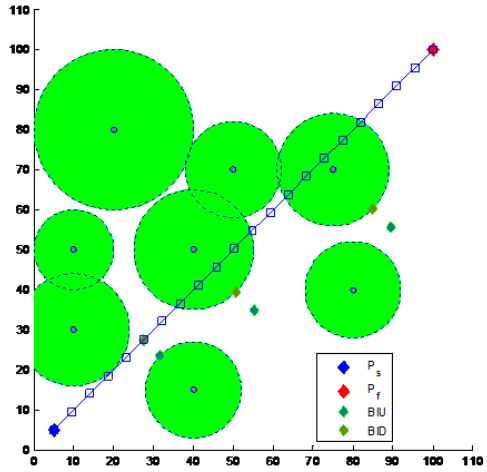
Fig. 4 The upper and lower initial limits of the population